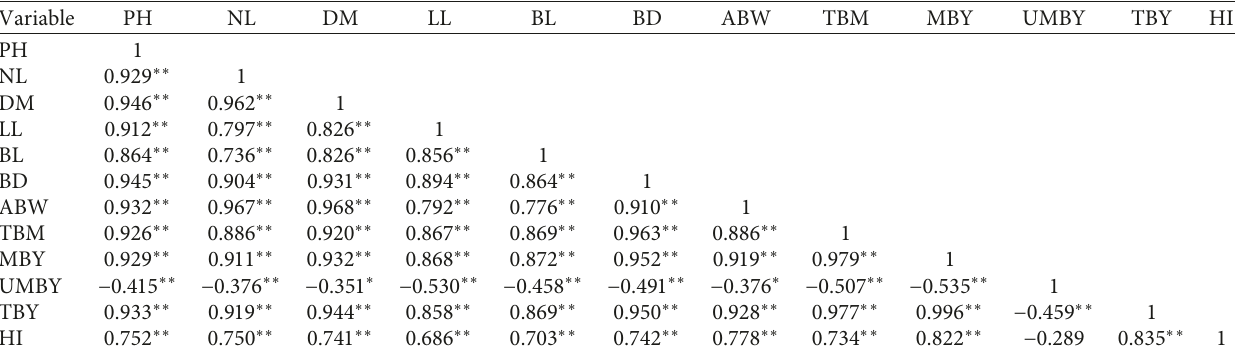
Table 7: Simple coefficients of correlation between plant growth, yield, and yield components of onion. Variable